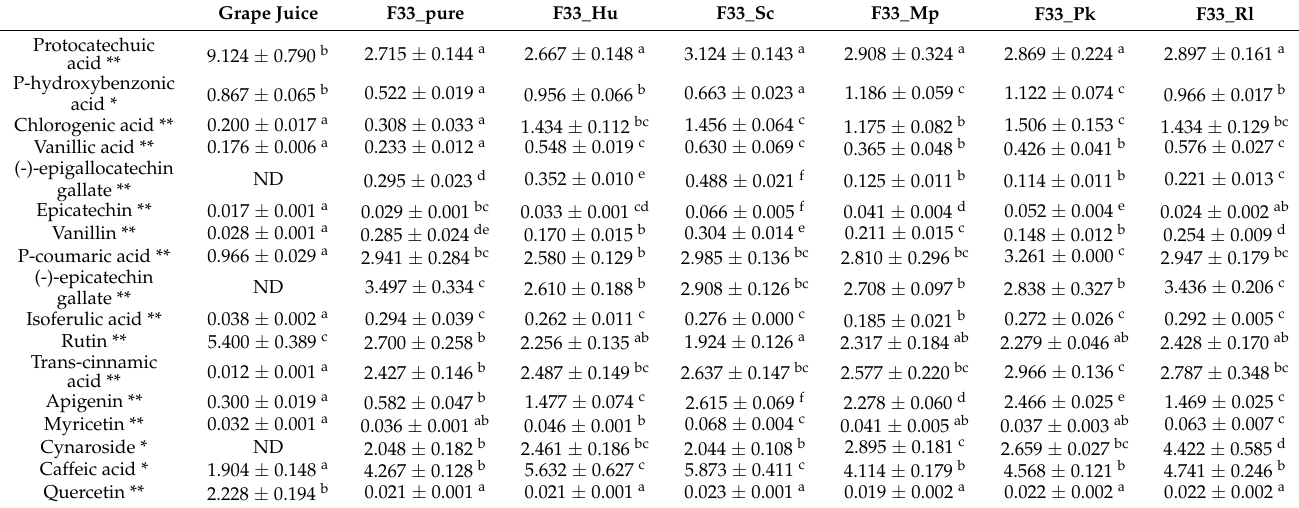
Data are mean values of three independent experiments ± standard deviation. Mean values displaying different letters within each row are significantly different according to the Duncan test at 95% confidence level. pure_F33: fermentation with S. cerevisiae F33 in